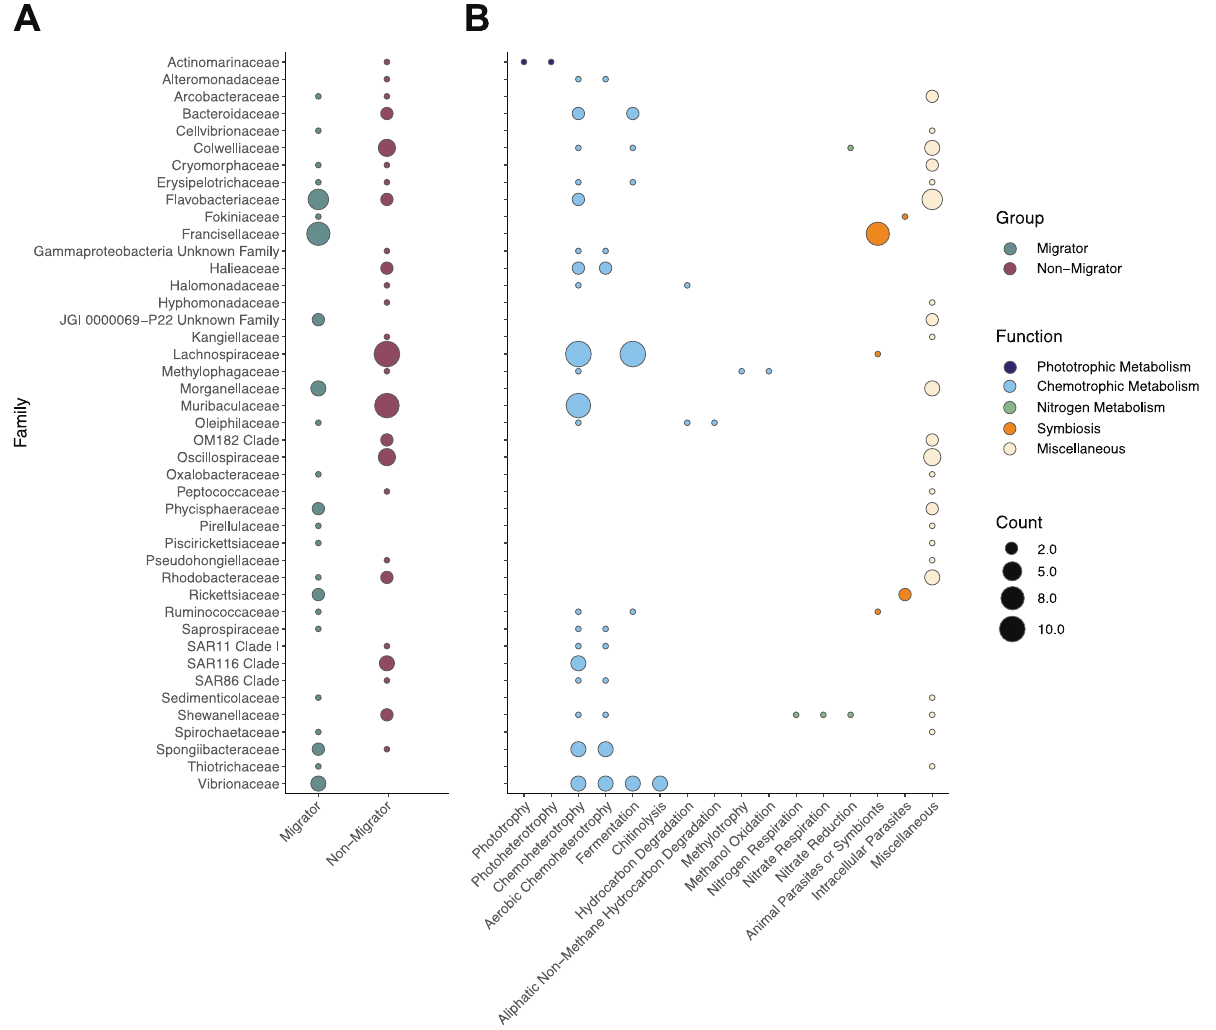
Fig. 3 Differences in abundance of microbial taxa based on host vertical migration status. Overview of differentially abundant ASVs grouped by microbial family between diel vertical migrators and non-migrators ( A ) and their respective functional characteristics as inferred by F APROTAX ( B ). A total of 100 ASVs showed signi fi cant differences in abundance based on a zero-in fl ated log-normal model at an alpha value < 0.1, with 57 and 43 being overrepresented in non-migrators and migrators, respectively. Dot sizes are scaled to the number of ASVs in each family ( A ) or the number of ASVs with particular metabolic functions ( B